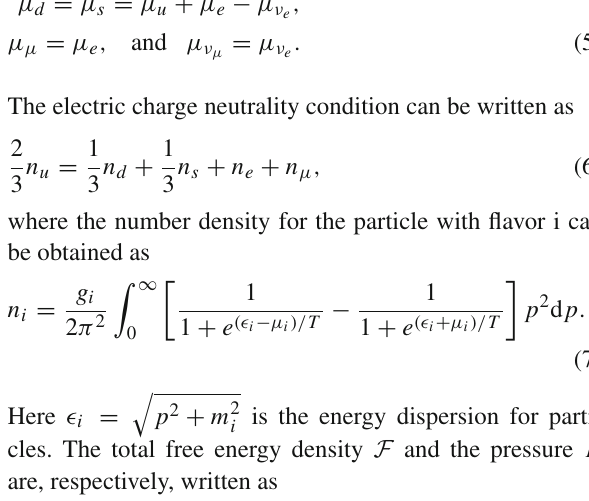
number density within the quasiparticle model with differ- ent parameter sets at the temperature of 0, 30 MeV, and 50 MeV. Considering the absolute stability for quark matter, the parameters are set as g-2 ( g = 2 , B 1 / 4 = 141 MeV), g-3 ( g = 3 , B 1 / 4 = 136 MeV), g-4 ( g = 4 , B 1 / 4 = 131